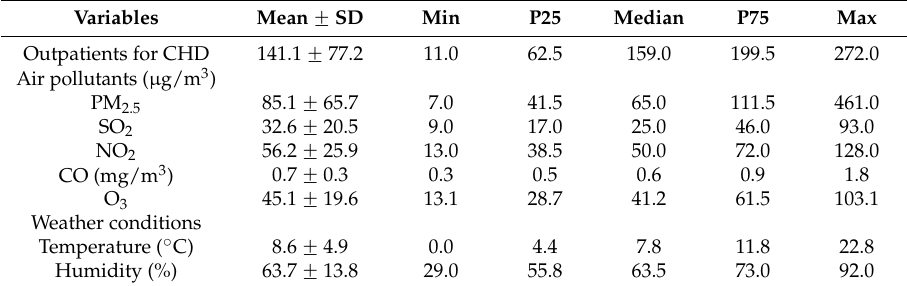
Table 1. Descriptive statistics of outpatient visits for coronary heart diseases (CHD), air pollutants, and weather conditions from 1 November 2013 to 28 February 2014 (120 days in total), in this study.